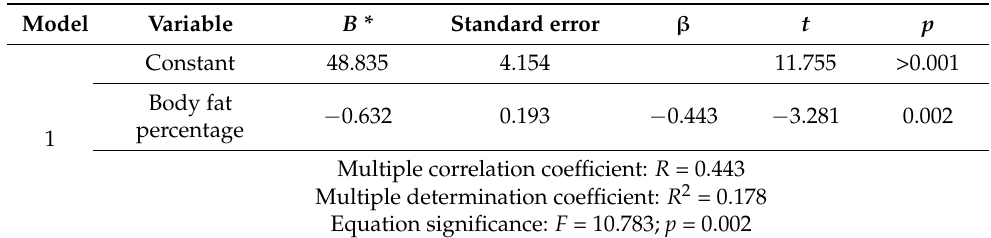
Table 9. Stepwise multiple regression of maximal oxygen uptake in relation to body fat percentage in the male